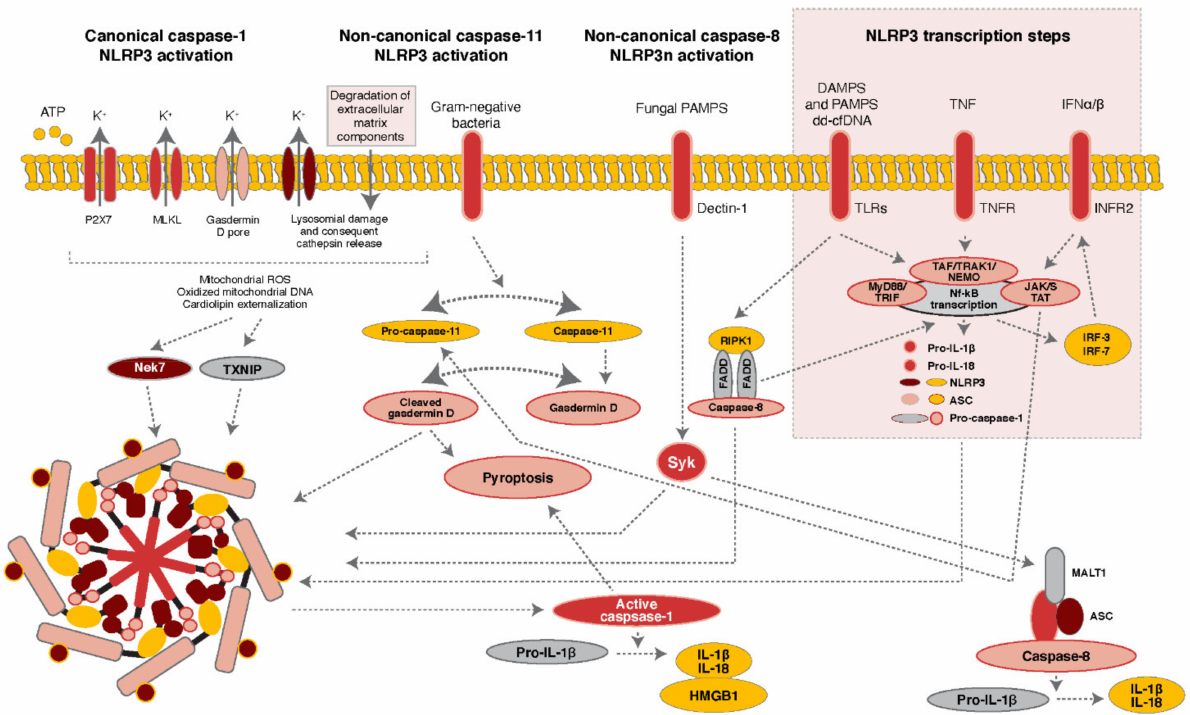
Figure 1. NLRP3 inflammasome signaling in transplantation. This diagram displays the molecular mechanisms under- lying NLRP3 inflammasome activation, with an emphasis on those specific to solid organ transplant. Classical Canonical NLRP3/caspase-1 activation: P2X7 receptor activation by extracellular ATP leads to MLKL activation. Exposure to pore- forming gasdermin D combined with lysosomal damage and cathepsin release promote potassium efflux, with consequent release of oxidized mitochondrial DNA and dd-cfDNA—leading to increase in mitochondrial ROS and cardiolipin exter- nalization. This in turn promotes NLRP3 inflammasome oligomerization and activation with the consequent release of IL-1 β ,IL-18, and HMGB1 and the autocatalytic cleavage of caspase-1. This active form of caspase-1 is also a major driver of the cell death pathway pyroptosis (see main text). Non-canonical caspase-11-dependent NLRP3 activation—bacterial infection in transplant: Gram-negative bacteria activate caspase-11, cleaving pore-forming gasdermin D between the N-terminal and +15]C-terminal domains. Cleaved gasdermin D promotes pyroptosis and the activation of canonical